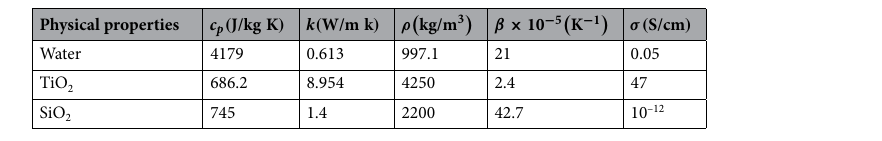
Table 1. Thermo-physical aspects of the nanoparticles and the fluid (TiO 2 –SiO 2 /water) (50/50) 45,50–53 .